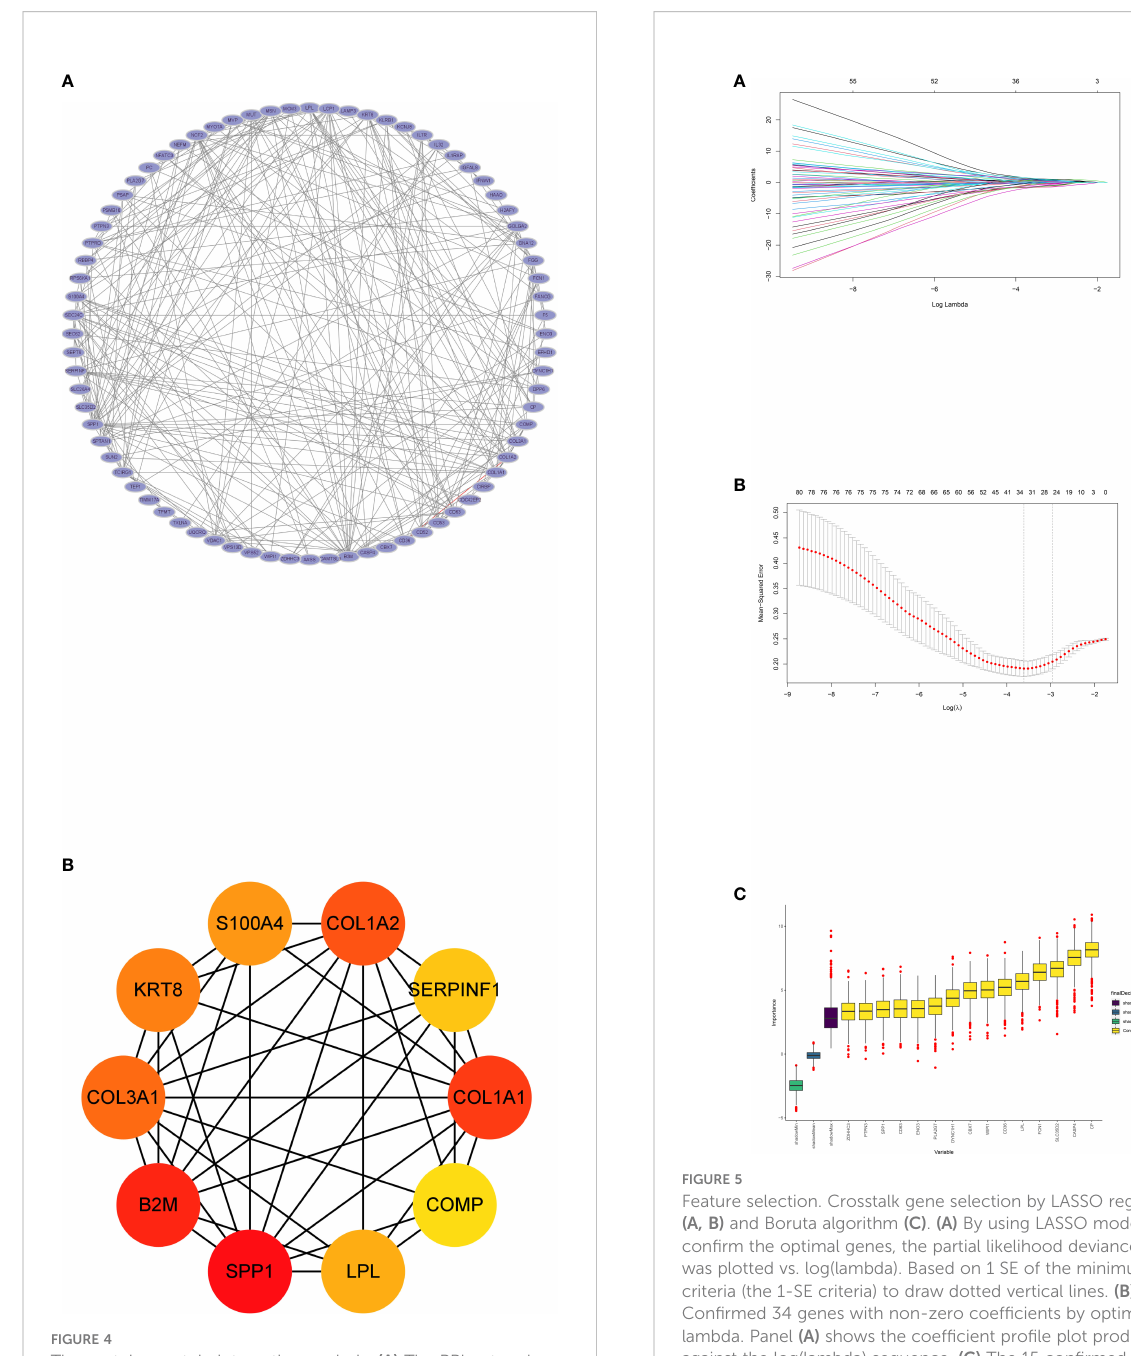
FIGURE 5 Feature selection. Crosstalk gene selection by LASSO regression (A, B) and Boruta algorithm (C) . (A) By using LASSO model to con fi rm the optimal genes, the partial likelihood deviance curve was plotted vs. log(lambda). Based on 1 SE of the minimum criteria (the 1-SE criteria) to draw dotted vertical lines. (B) Con fi rmed 34 genes with non-zero coef fi cients by optimal lambda. Panel (A) shows the coef fi cient pro fi le plot produced against the log(lambda) sequence. (C) The 15 con fi rmed genes were indicated by the yellow box. X-axis represents selected genes. Y-axis represents the score of each